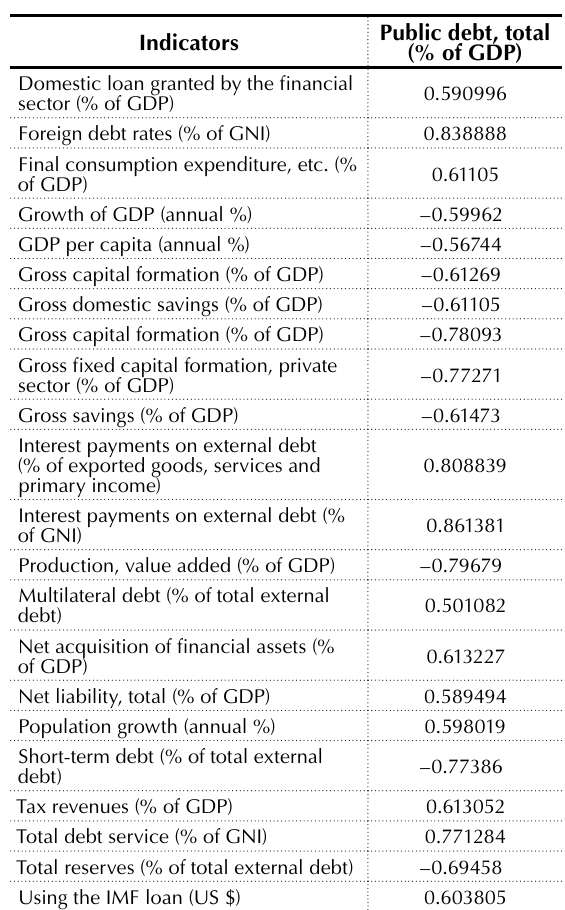
Table 3 (cont.). Correlation coefficients of the